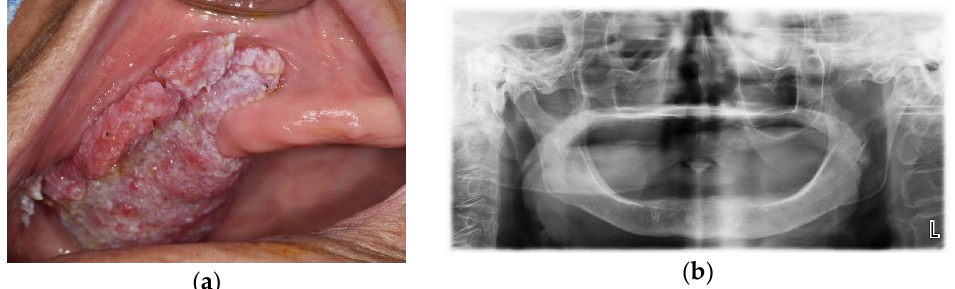
Figure 10. Initial examinations: ( a ) intraoral photograph showed the proliferative lesion with indis- tinct borders on the right upper gingiva; ( b ) panoramic view.